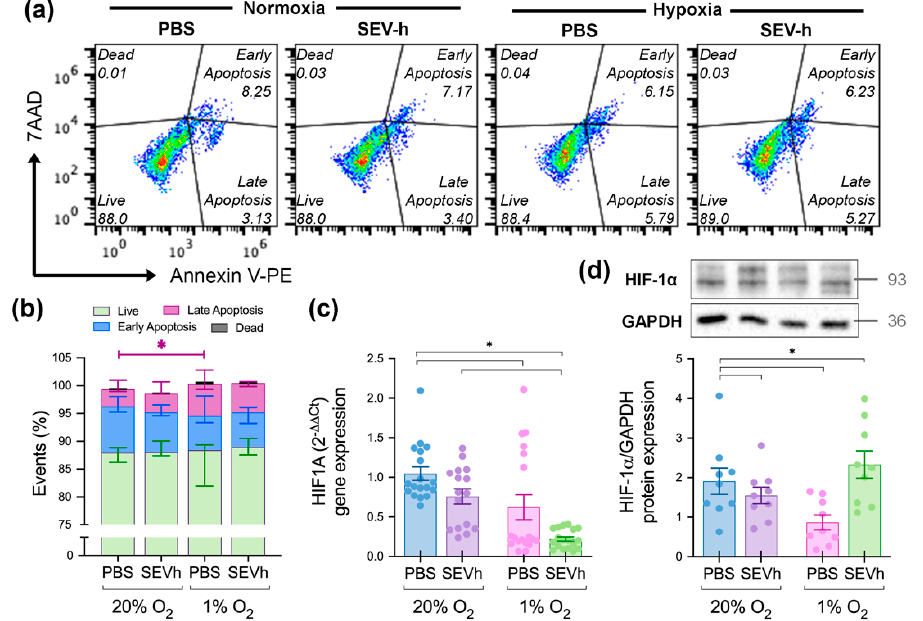
Figure 5. HIF-dependent cell responses resulted from SEVh treatment. ( a ) Scatter plot of apoptosis assay; population (%) displayed as average of two independent assays in technical triplicates. ( b ) Comparative graph of the four possible outcomes for cells (live, early apoptotic, late apoptotic, or dead) as determined by the apoptosis assay. Statistical significance obtained from early apoptotic cells between untreated groups (normoxia × hypoxia), as indicated in the fuchsia bar above ( c , d ) Levels of HIF-1 α ( c ) gene expression (mean ± SEM) and ( d ) whole cell protein expression (mean ± SEM) (* p < 0.05).